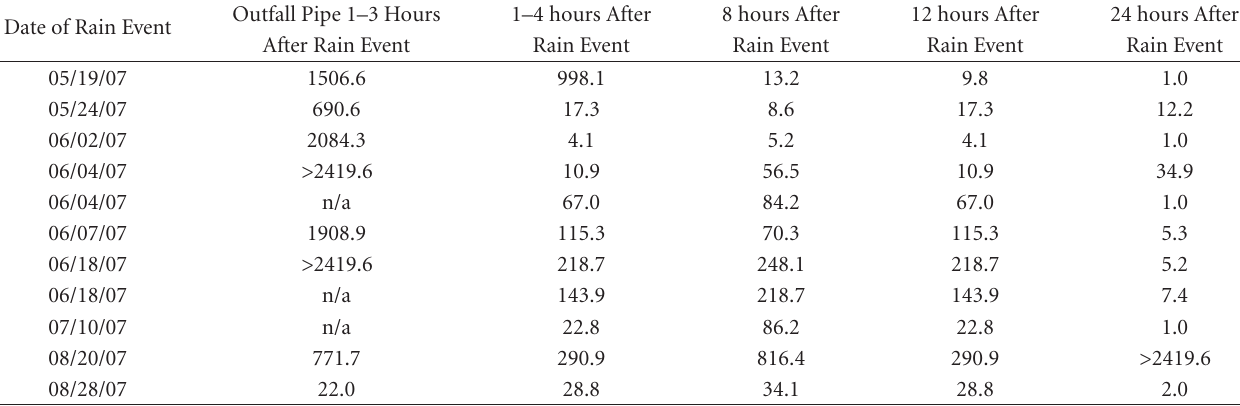
Table 2: E. coli concentrations ( ∗ MPN/100mL) from beach water collected at time intervals following the triggering of a rain event at Bailey’s Harbor beach. Using Sche ff e matrix analysis, only E. coli concentrations measured in the first four hours after the rain event was triggered were significantly di ff erent from the seasonal mean E. coli concentration for this beach ( P < . 001). If rainfall was su ffi cient to trigger multiple rain event notifications on one day, then multiple events were sampled.